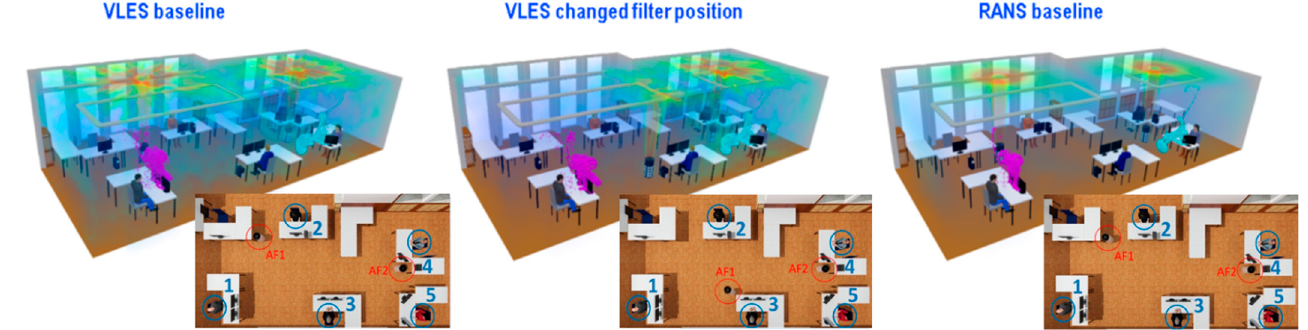
Figure 15. Distribution of the particle concentration for a coughing scenario simulated after 25 s using different simulation methods and positions of the air cleaner.